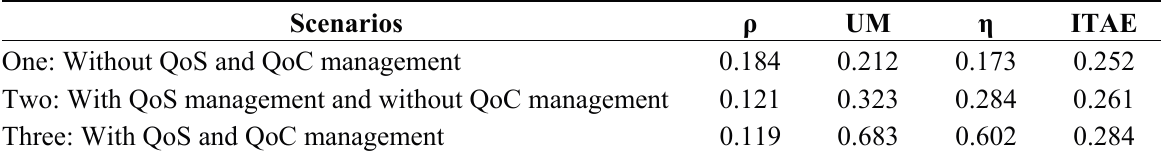
Table 1. Experimental results based on different scenarios (average values).